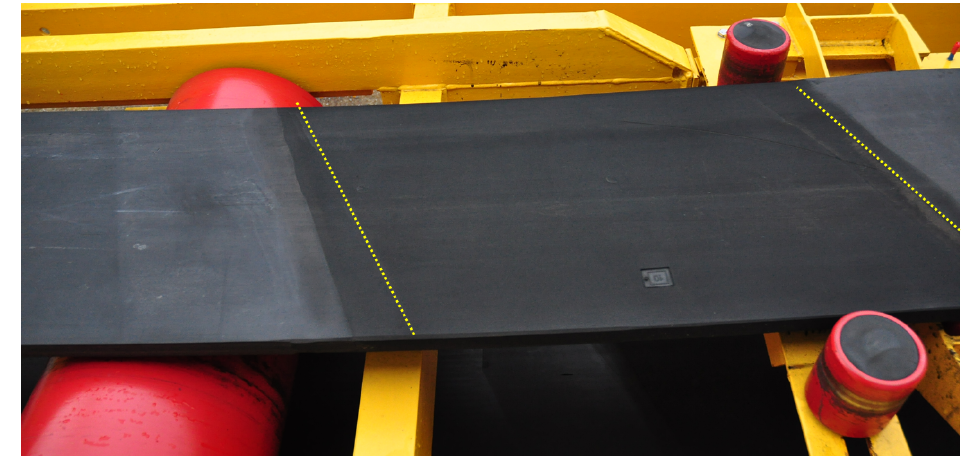
Figure 6. Picture of the conveyor belt with splices.